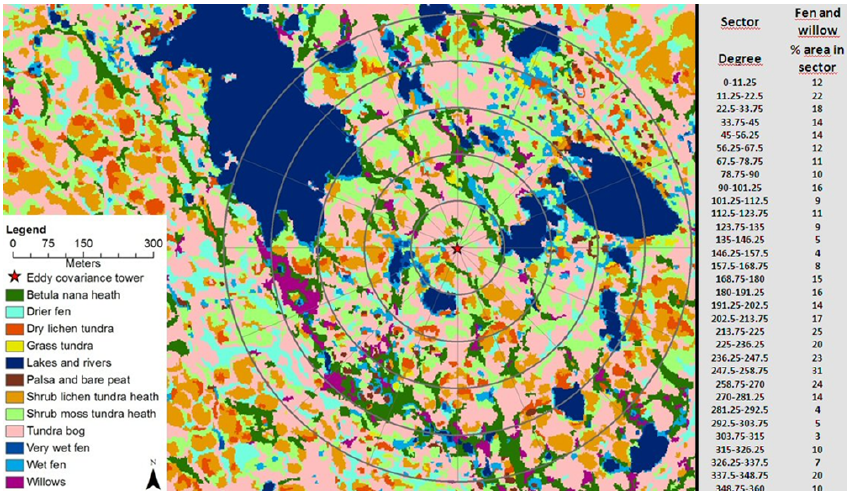
Figure 1. Land cover classification of the field site employing QuickBird satellite imagery. The eddy covariance (EC) tower is indicated by a star, concentric lines drawn around the tower at 100m intervals represent the EC footprint area. Areal coverage of fen and willow land cover types in different sectors from the EC tower is shown in a table to the right of the figure, zero refers to north.